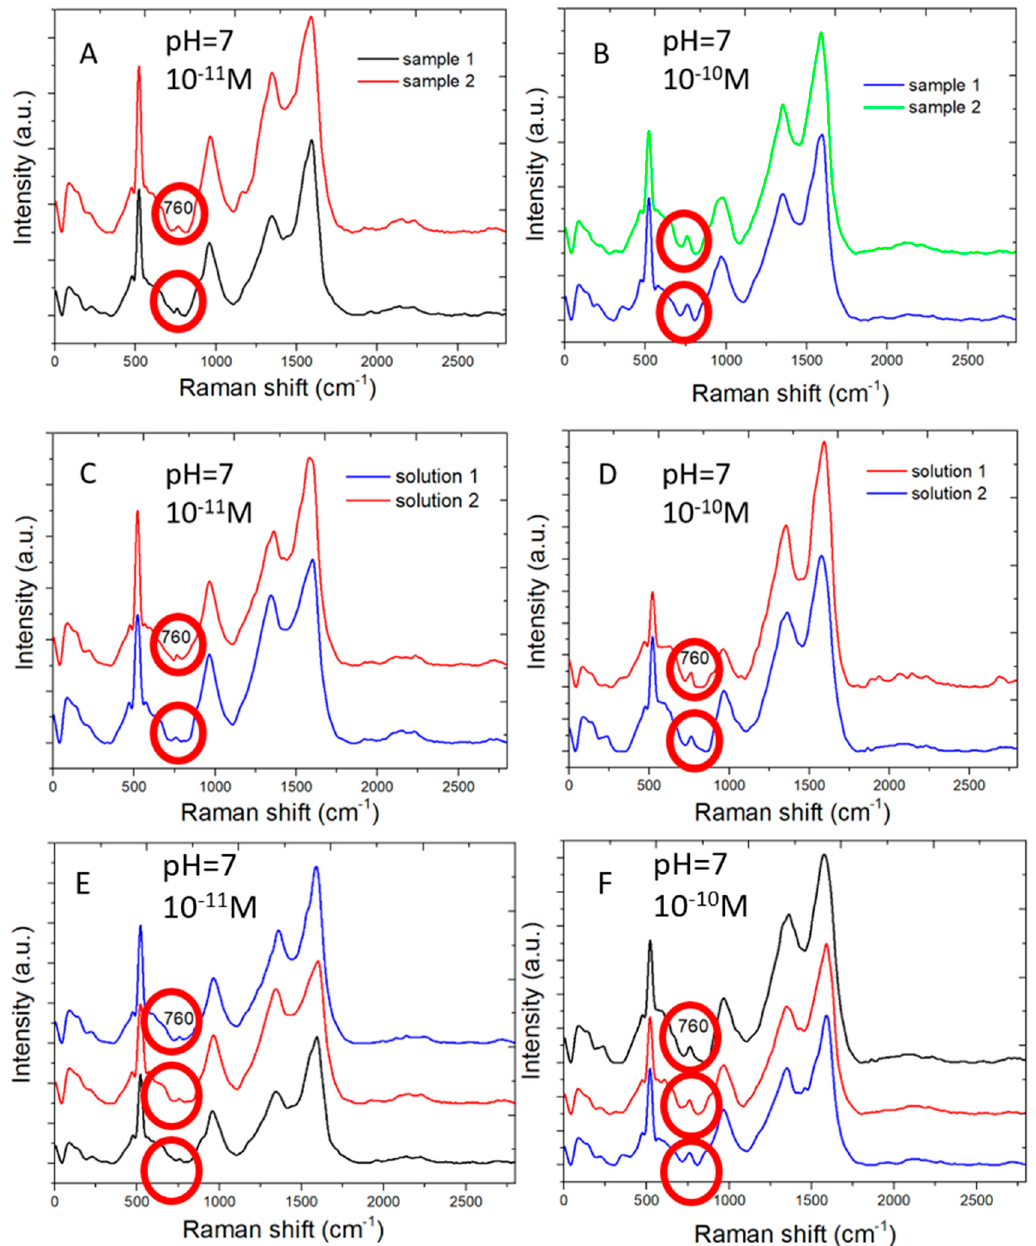
Figure 6. Multiple Raman spectral measurements: ( A ) Raman spectra measured from 10 − 11 M adenine molecules in water by two different SERS sensors. ( B ) The same as ( A ) but for 10 − 10 M concentration. ( C ) Raman spectra measured from two different water solution of 10 − 11 M adenine by the same SERS sensor. ( D ) The same as ( C ) but for two water solution of 10 − 10 M adenine. ( E ) Raman spectra measured at three different areas of a SERS sensor from 10 − 11 M adenine molecules in water. ( F ) The same as ( E ) but for 10 − 11 M adenine molecules in water.